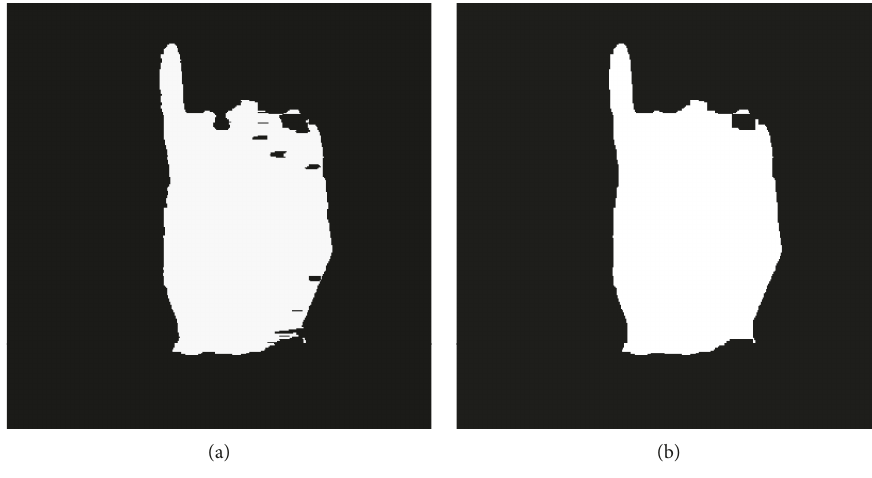
Figure 8: Segmentation after erosion (a) and closing (b).